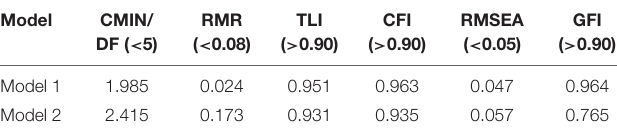
TABLE 3B | Model fit indices.